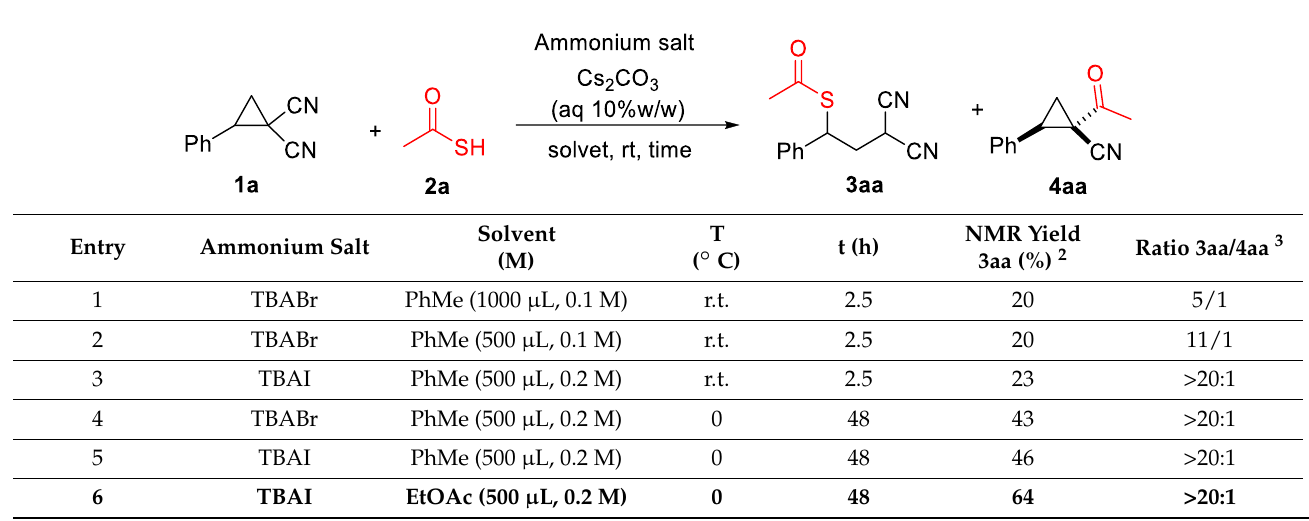
Table 3. Reaction condition screening 1 .